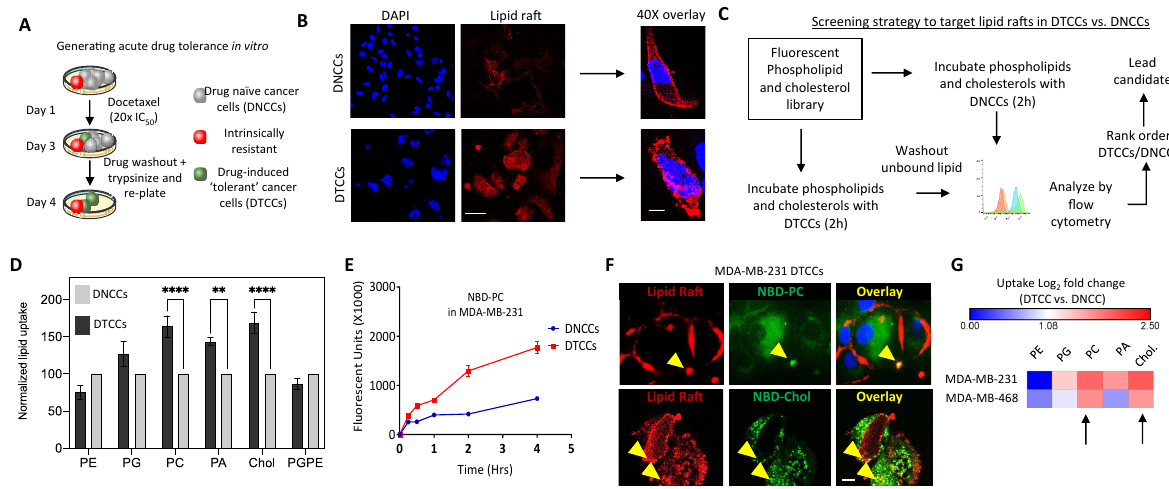
Figure 1: Lipid-based targeting of drug tolerant cancer cells (DTCCs). (A) Schematic representation of the experimental strategy for the generation of acute drug tolerant cancer cells (DTCCs) in vitro . (B) Representative fl orescent microscopy image of the lipid raft formation in drug naïve cancer cells (DNCCs) and DTCCs. Lipid raft labeling (red) and DAPI (blue). Scale bar = 10 μ m right panel shows 20 × image, scale bar = 3 μ m. (C) The experimental work fl ow of the lipid screening strategy. (D) Histogram shows the normalized uptake of the lipid raft-targeting agents in DNCCs and in DTCCs. The fl uorescent intensity obtained in each case has been recorded and normalized according to the DNCC fl uorescence intensity. ** p < 0.01 **** p < 0.0001 by t -test, N > 3 in biological replicate. (E) Trace shows uptake of NBD-PC [5 μ M] into MDA-MB-231 DTCCs or DNCCs over time. Units are in arbitrary fl uorescence as determined by fl ow cytometry, N = 3 in biological replicate. (F) Representative image showing the colocalization of lipid rafts and NBD-PC or NBD-cholesterol. DTCCs were incubated with NBD-PC/Cholesterol (green) and stained with lipid raft labeling agent red. These data demonstrates the internalization of the NBD-PC lipid across the lipid raft present on the cellular membrane performed in biological replicates.Scalebar=10 μ m.(G)Heatmapshowsthechangein fl uorescenceintensityofDTCCsrelativetoDNCCsfromtwoTNBCcelllines(log 2 fold change) as determined by fl ow cytometry. Arrows indicate lipids with increased uptake in DTCCs of both cell lines